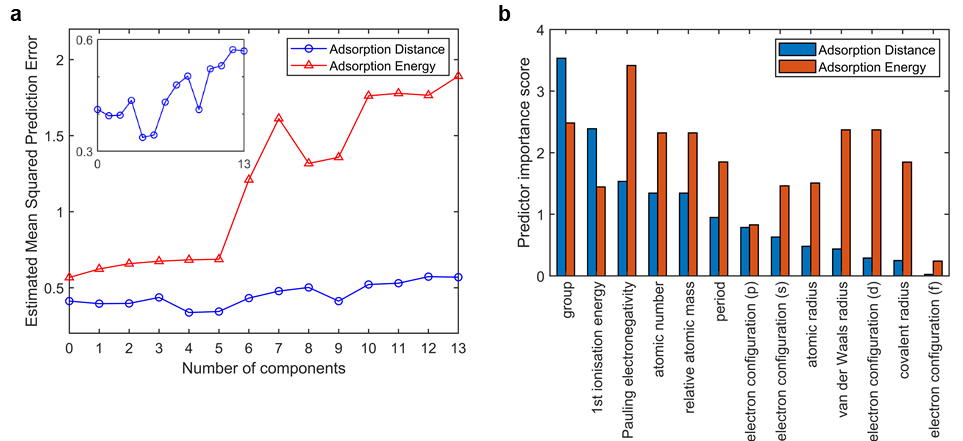
Figure 3. Feature selection. ( a ) Prediction error curves with number of inputs (the detailed plot of adsorption distance output is shown in northeast) with principal components regression (PCR) and ( b ) feature importance bar using F-tests. In both subfigures, the red bar represents adsorption energy output and the blue bar represents adsorption distance output.